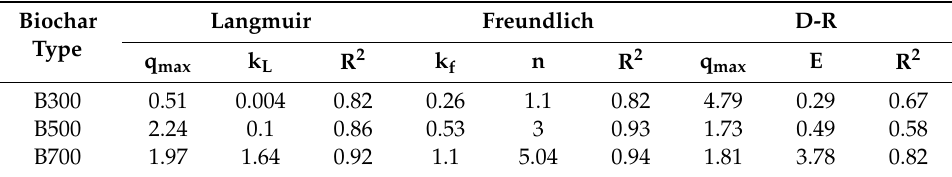
Table 3. Fitting results of different adsorption isotherm models 1 .